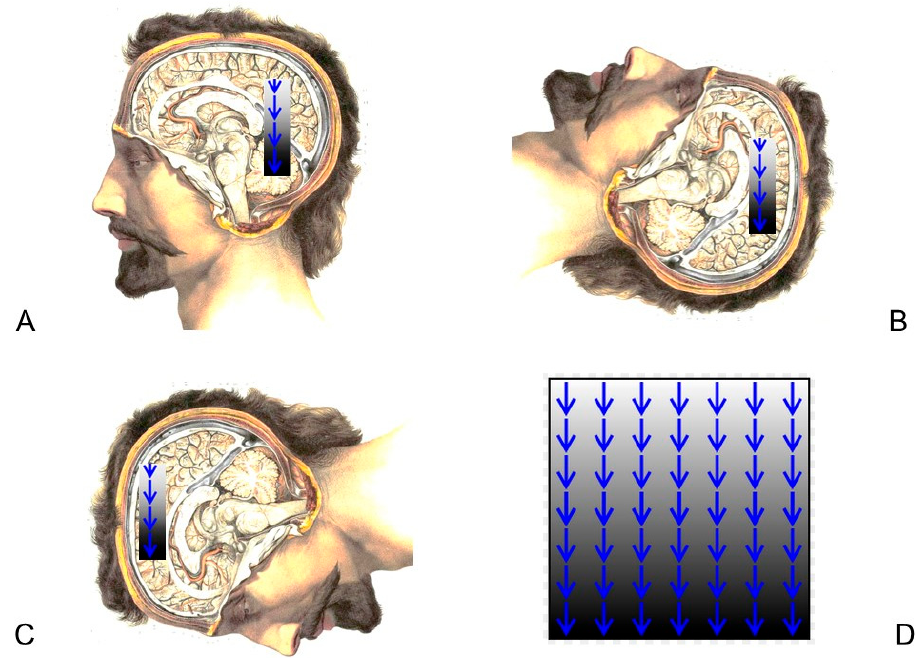
Figure 1. ( A ) Mid-sagittal view of the brain in relation to eye, face, and neck. Vertical (upright) position. Gravity (arrows) is pushing the cerebral hemispheres toward the brainstem and cerebellum. ( B ) Horizontal supine position. ( C ) Horizontal prone position. ( D ) Gravity. Schematic stratification of biological tissue into horizontally pancaking layers under the influence of gravity. Lower layers